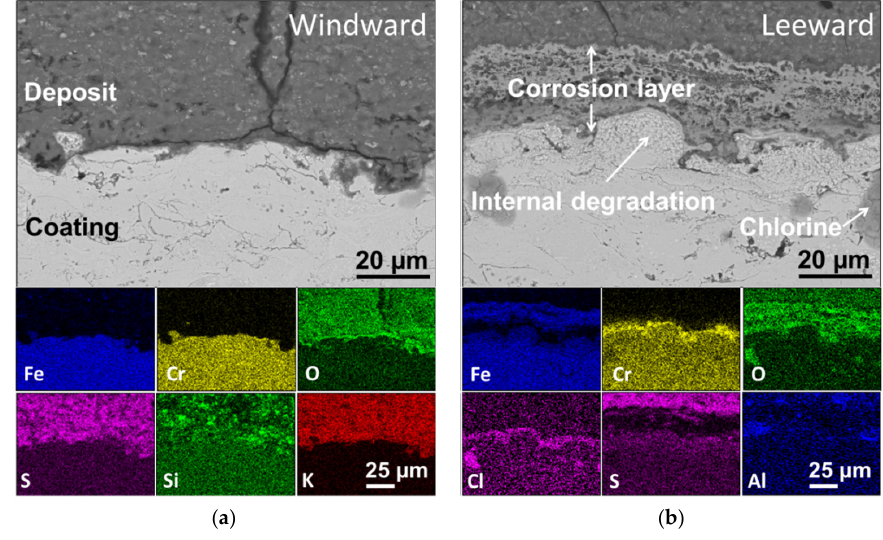
Figure 6. SEM (BSE) image of the outer surface of the FeCr coating and energy ‐ dispersive X ‐ ray spectroscope (EDX) map analysis from the windward ( a ) and leeward side ( b ).